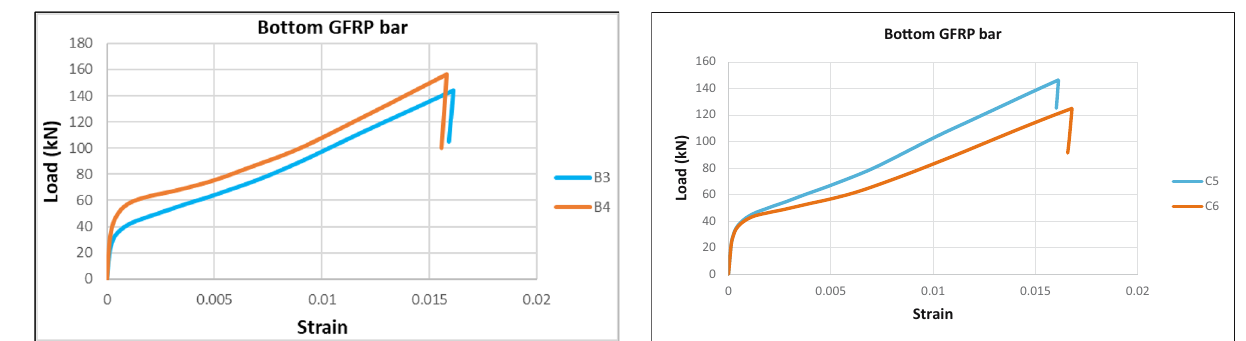
Figure 14: Strain of the bottom bar for specimens beams C5 and C6.